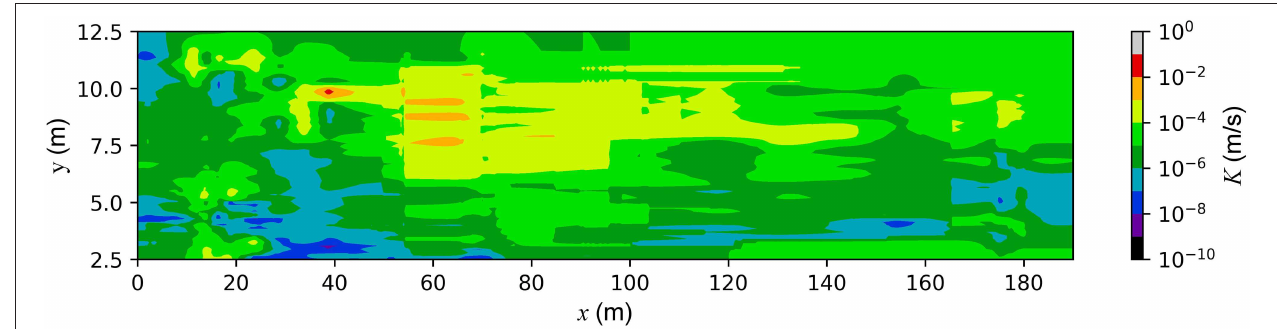
FIGURE 1 | The spatial distribution of Y = ln K in a cross section of the Columbus Air Force Base aquifer, where the MADE transport experiment took place (Boggs and Rehfeldt, 1990; Boggs et al., 1992). It is seen that K = exp ( Y ) has anisotropic structure and varies by several orders of